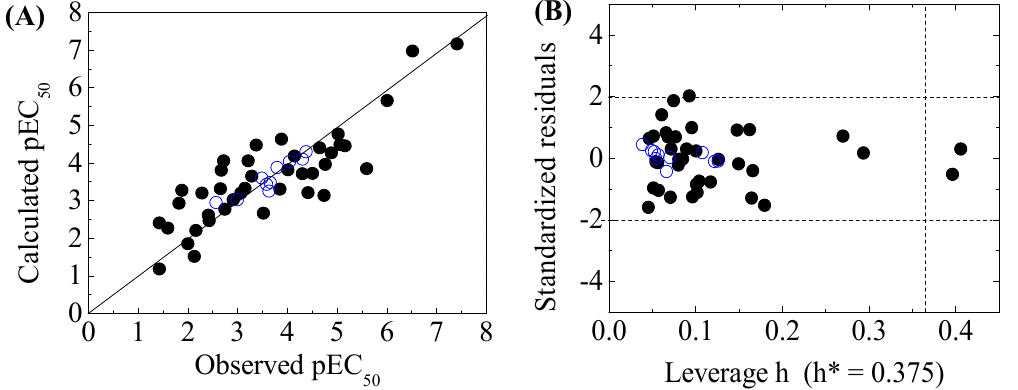
Figure 1. Scatter plot of observed versus calculated pEC 50 ( A ), and the Williams plot of the final model ( B ) for 50 disinfection byproducts to X-Microtox. “ ● ”: training set, “ ○ ”: test set. h*( warning leverage).